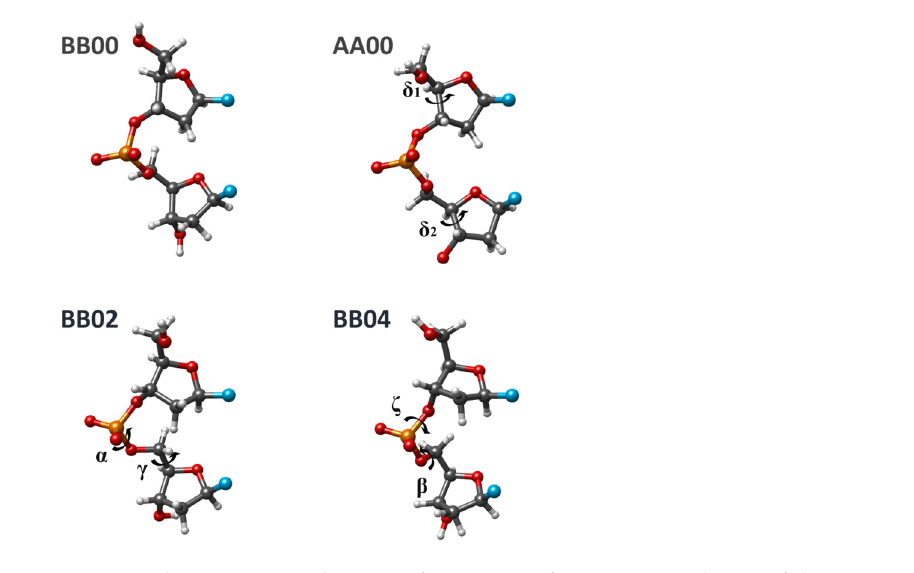
Figure 2. The experimental SPB conformations of various NtC classes of dDMPs. BB00, NDB ID PDT058 of the dCpdC fragment, and AA00, NDB ID PD0426 of the dCpdA fragment, correspond to the energy minima of separate SPBs. The torsion angles of BB02, NDB ID PD0311 of the dApdA fragment, and BB04, NDB ID 5ET9 of the dCpdG fragment, do not match the energy minima of separate SPBs. The labeled torsion angles indicate those that differ from the respective angles in BB00 NtC. The displayed structures indicate similarity in the position of glycoside bonds.